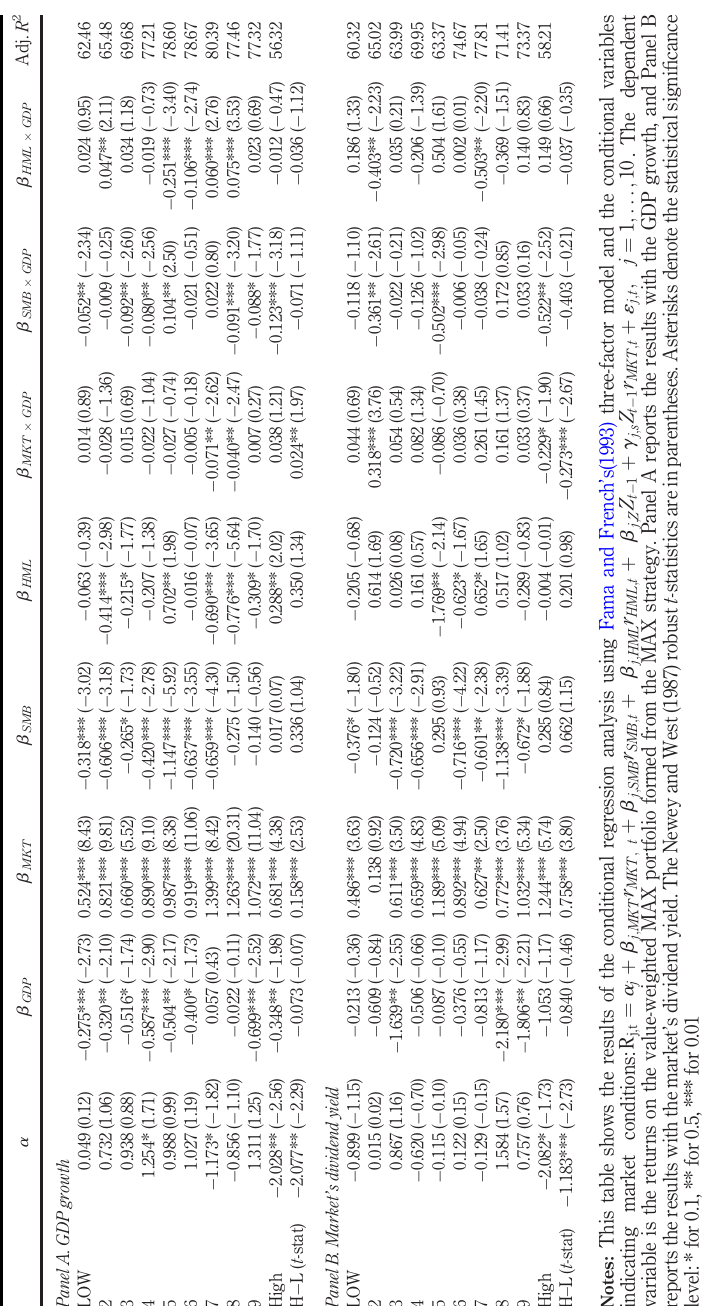
Table 9. Conditional regressions with GDP growth and market ’ s dividend